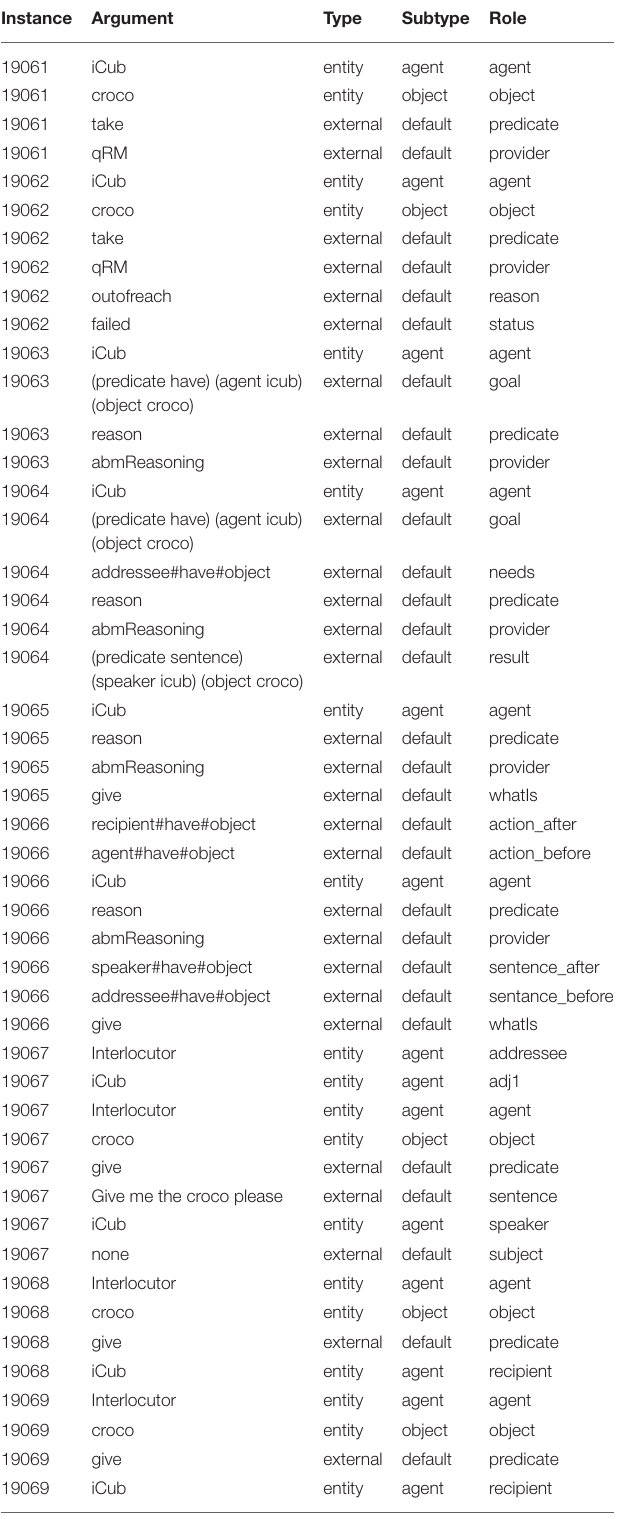
TABLE 7 | Argument content table. Instance